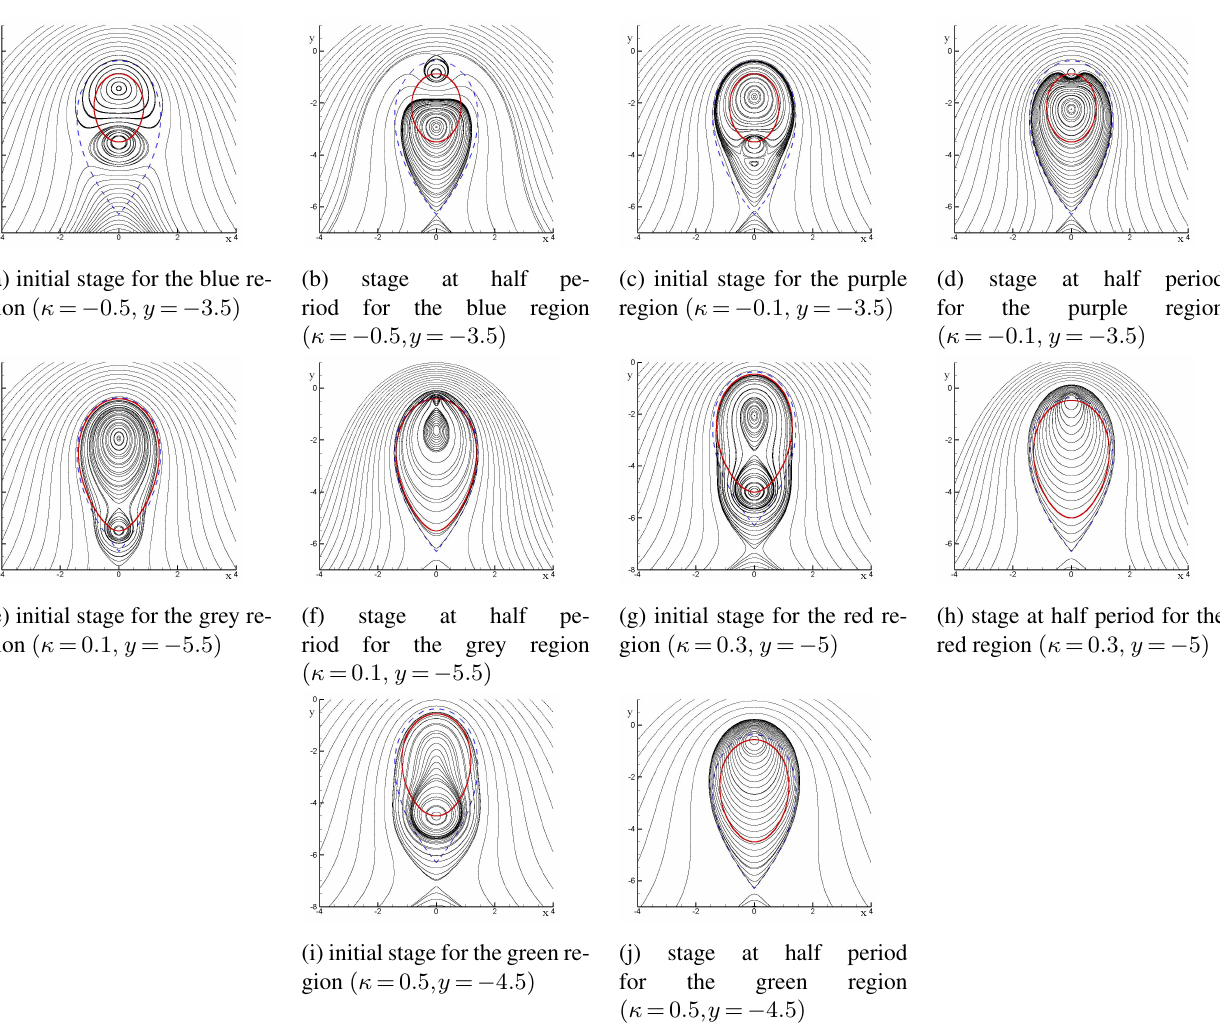
Fig. 5. Streamlines of the flow in the upper-layer monopole case. Red curve corresponds to the monopole motion trajectory. Dashed blue curve is the topographic vortex unperturbed separatrix.